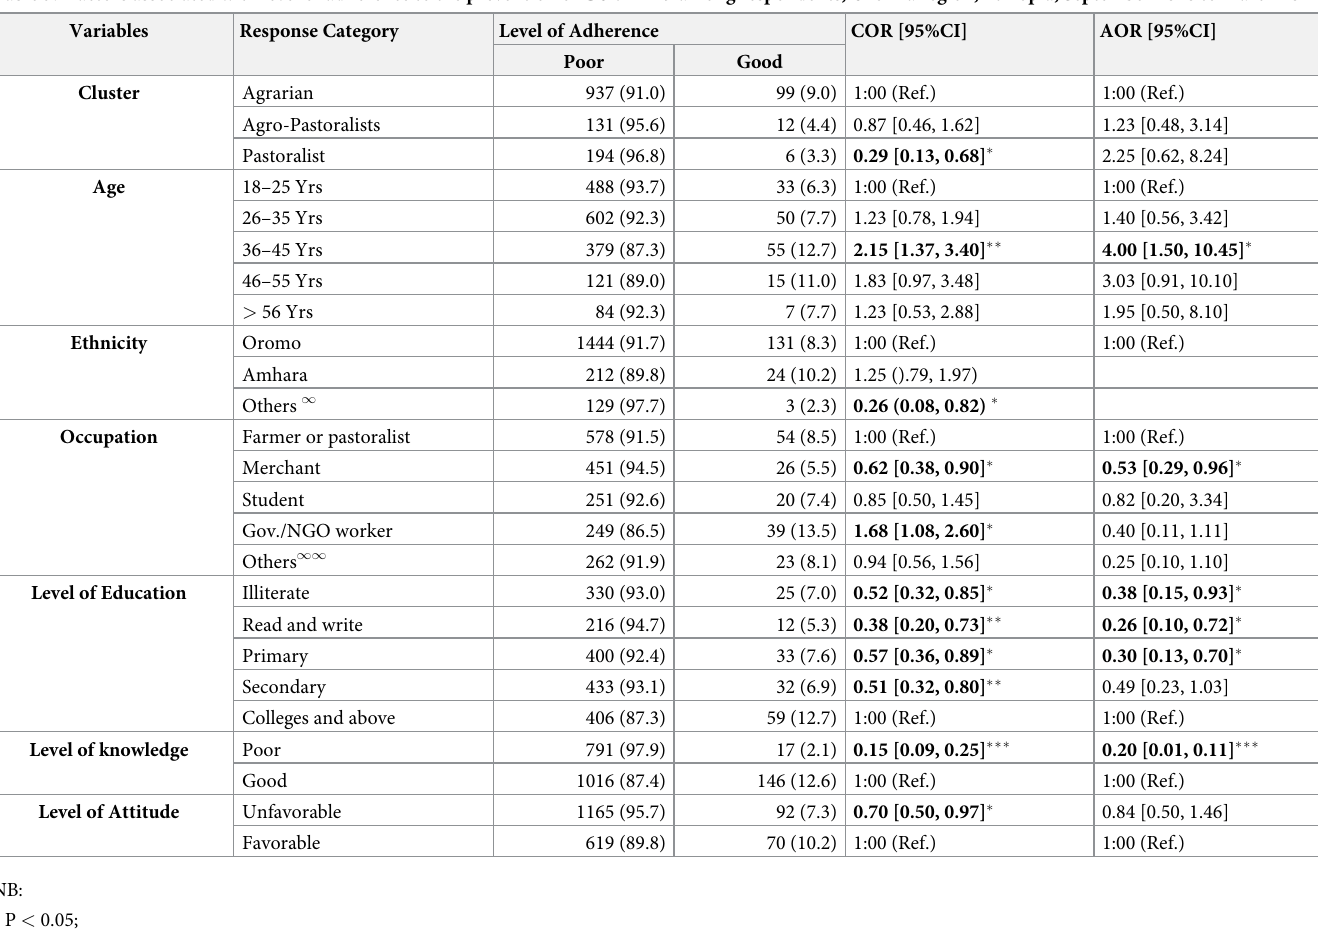
Table 5. Factors associated with level of adherence to the prevention of COVID-19 among respondents, Oromia region, Ethiopia, September 2020 to March 2021.